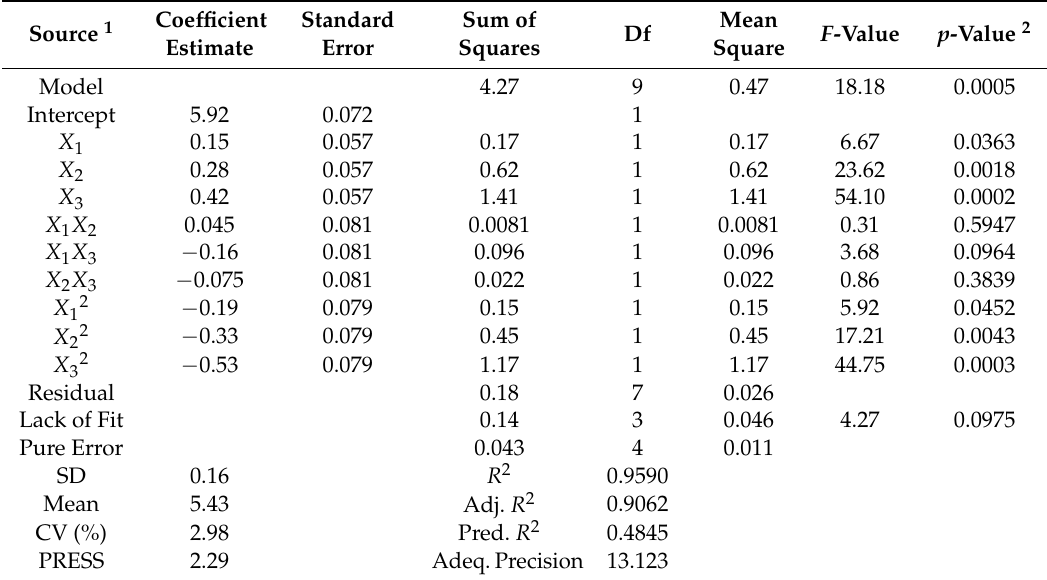
Table 2. The analysis of variance (ANOVA) for the quadratic polynomial mode.